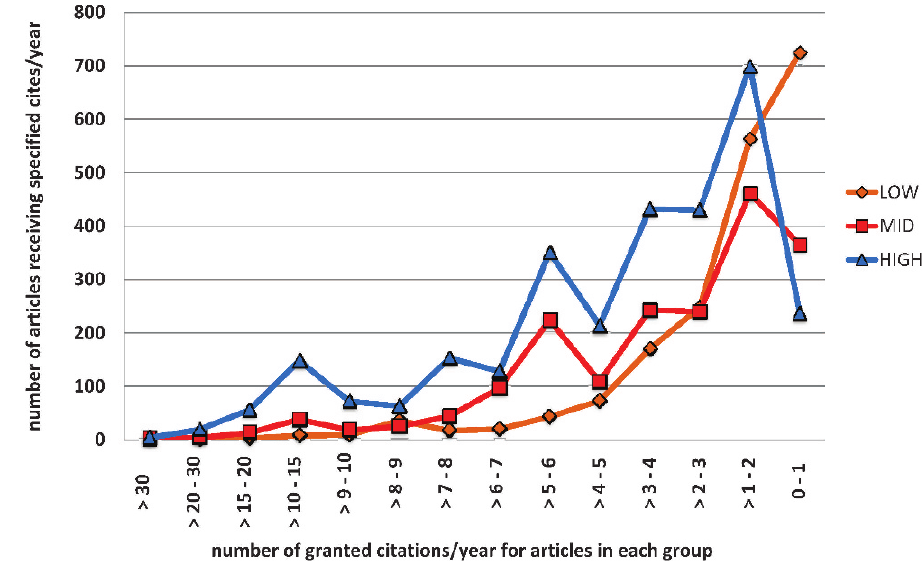
Figure 2 - Frequency distribution of articles according to cites/year: Groups LOW, MID and